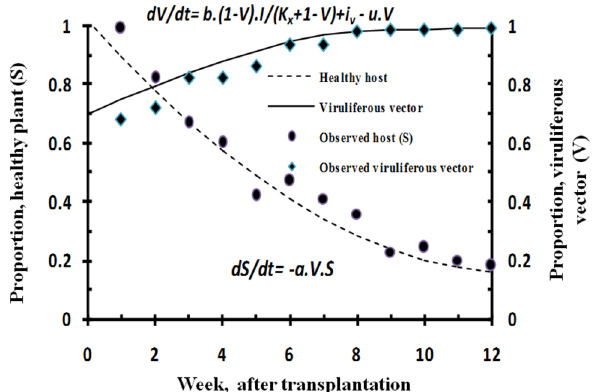
Figure 2. Simulated dynamics of healthy host ( S ) and viruliferous whitefly population ( V ) on susceptible chili cultivar(cvHPH-1041) grown (August–December, 2019) under natural infection conditions at experimental field, New Delhi; Model fitting parameters; transmission rate a = 0.12; acquisition rate b = 0.70; immigration rate ( i v ) = 0.34 and; mortality rate = 0.34; K x = 2.8; RMSE = 0.0105 (host) and 0.0167